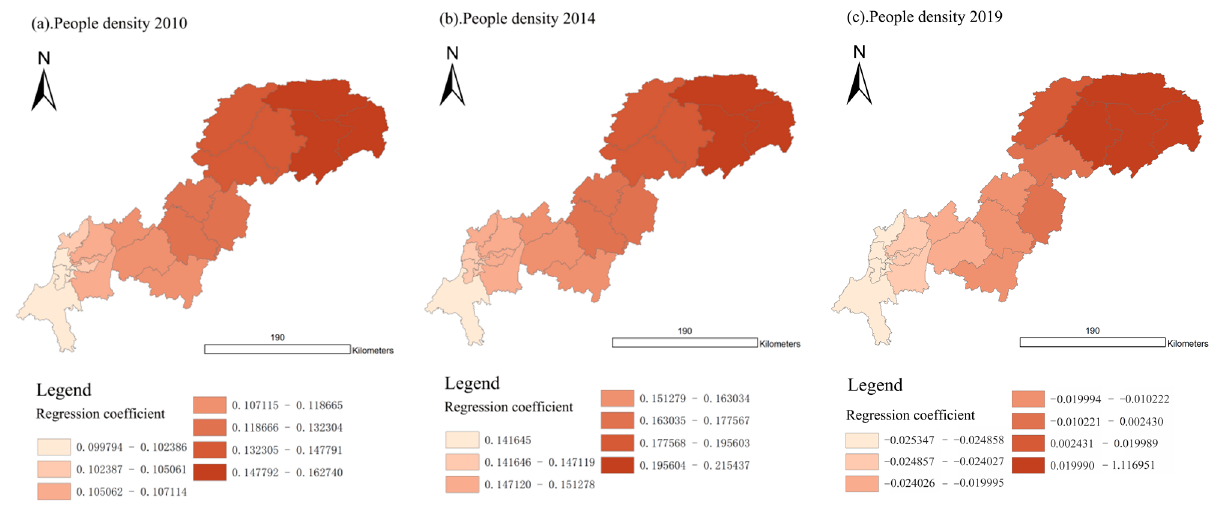
Figure 12. Spatial distribution of regression coefficient of P-UDI in year 2010, 2014, and 2019 (presented in subfigure a – c , respectively). Sources: Calculation results of the GWR model from the population dimension.